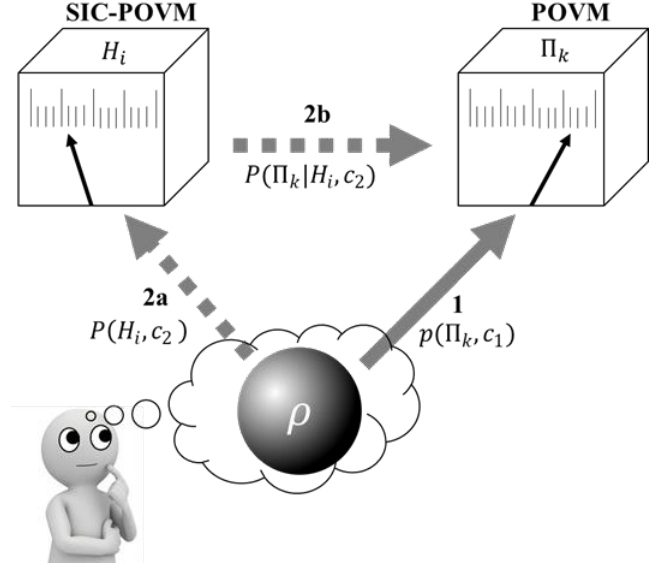
Figure 6. Schematic representation of the two alternative paths (1 and 2) for measuring the quantum state 𝜌 .